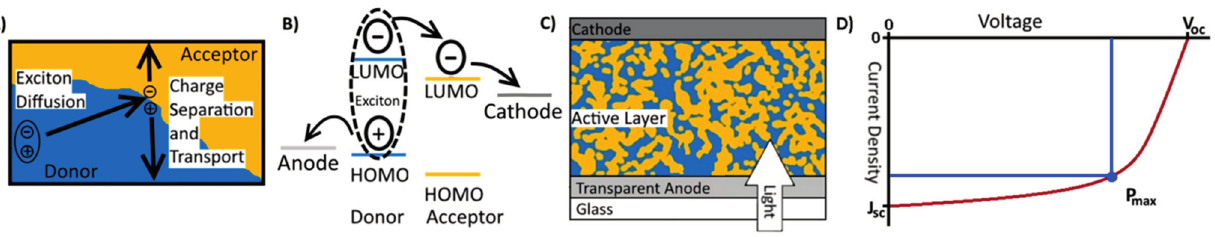
Figure 1. ( A ) Schematic of the main processes that take place in an organic solar cell; ( B ) Corresponding energy level diagram; ( C ) Bulk heterojunction solar cell structure; ( D ) Typical electrical characteristics of an organic solar cell with the J – V curve in red and the current density and voltage at P max shown in